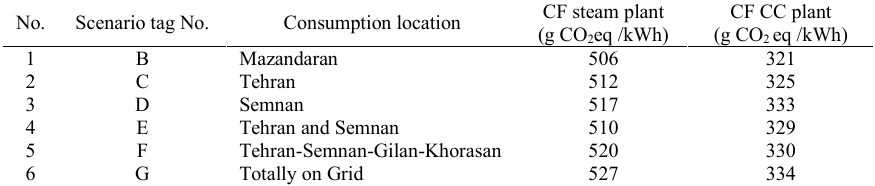
Table 8: Third group of scenarios investigating site condition on carbon footprint